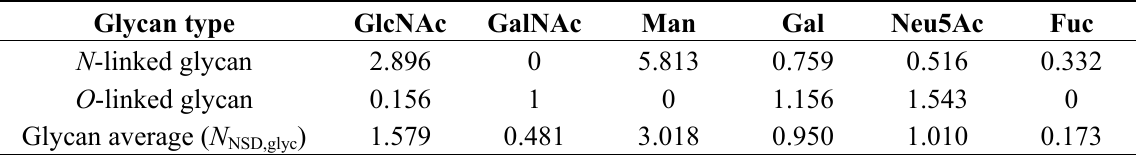
Table 1. Frequency of sugar species occurrence in glycans of mature human B-cells. Glycan